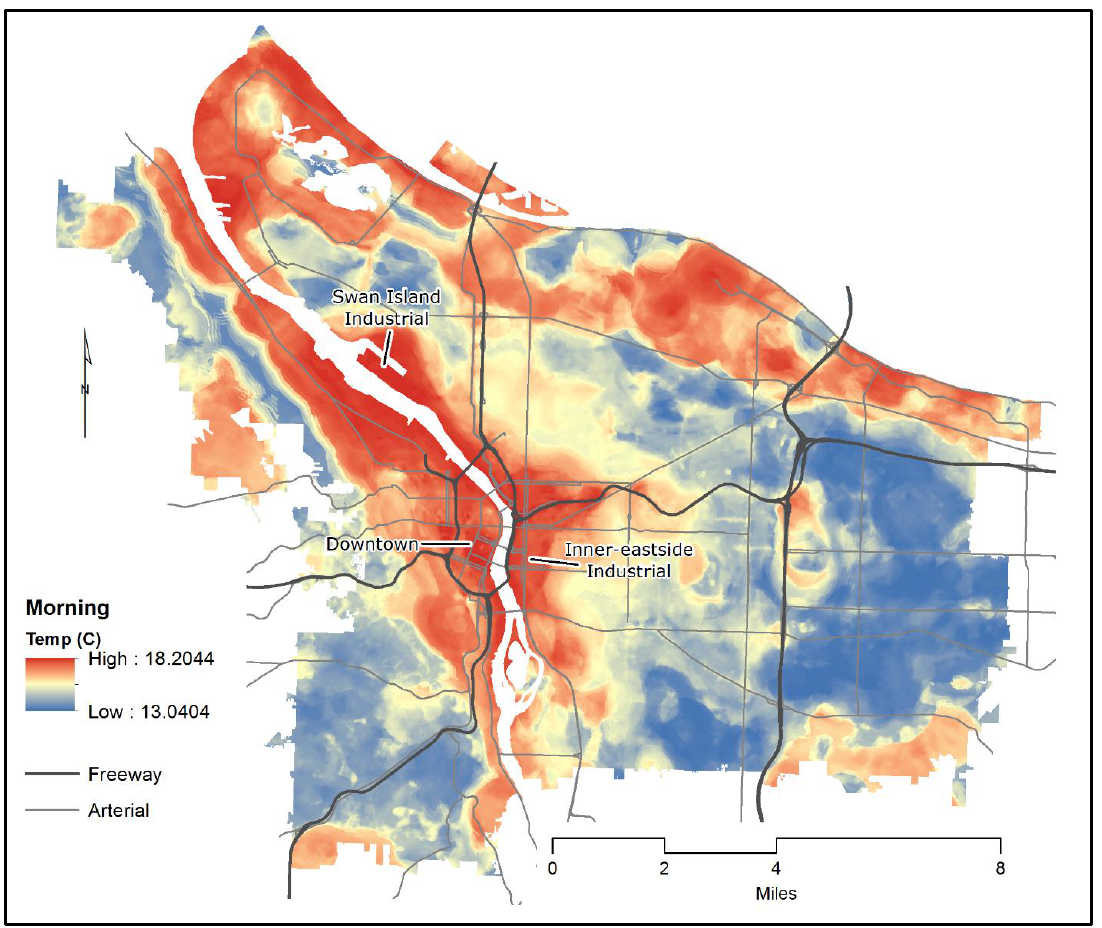
Figure 4. Morning UHI modeled raster surface. The river has been masked out visually, however summary statistics incorporate its values. summary statistics incorporate its